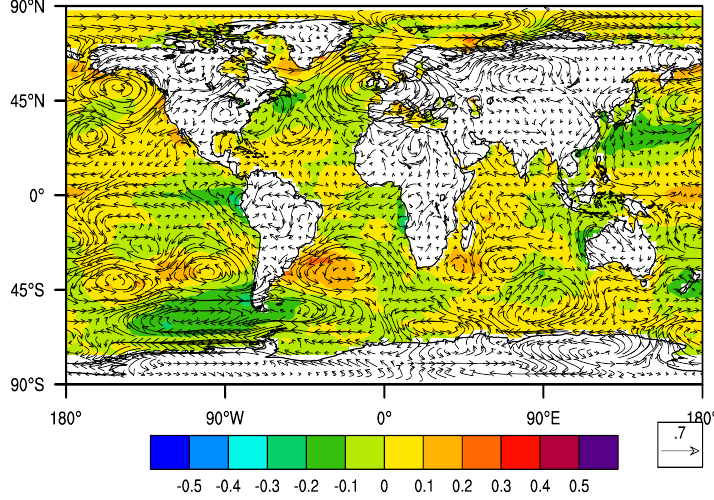
Figure 14. Wind and sea surface temperature anomaly composites for EOF1 during the Long Rains over the Lake Victoria domain using the TRMM